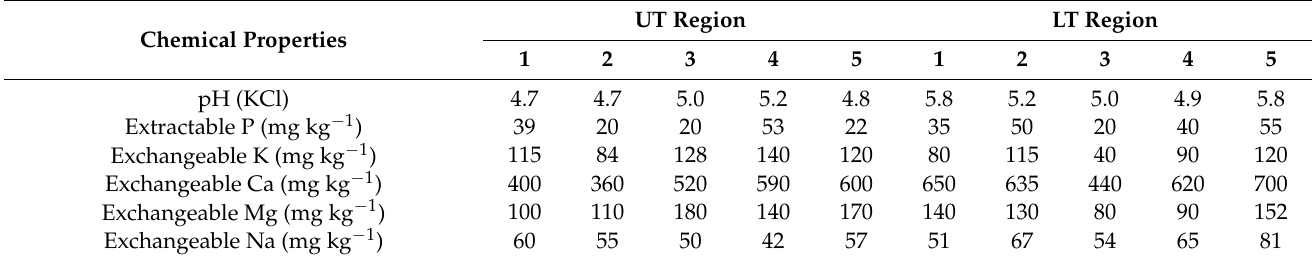
Table 3. Mean pH and nutrient status of soil to 30 cm depth in dairy farms in the Upper (UT) and Lower (LT) Tsitsikamma